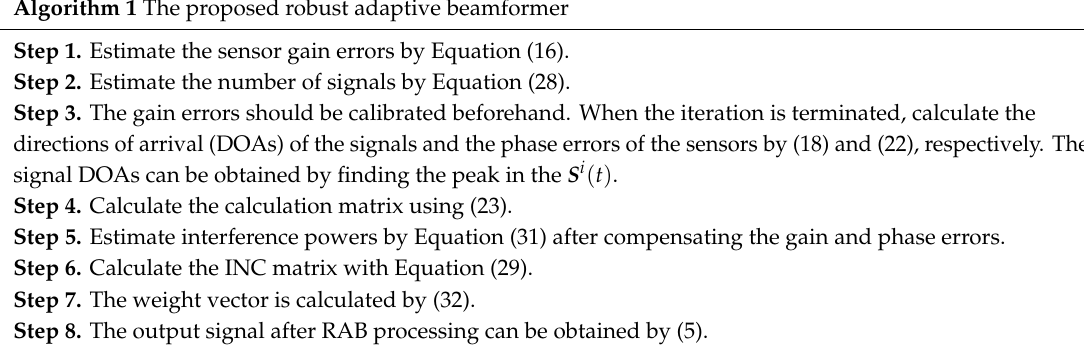
Algorithm 1 The proposed robust adaptive